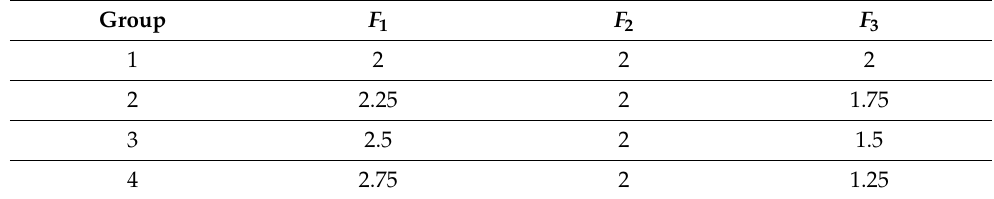
Table 2. F k of charger in each region with M = 1.